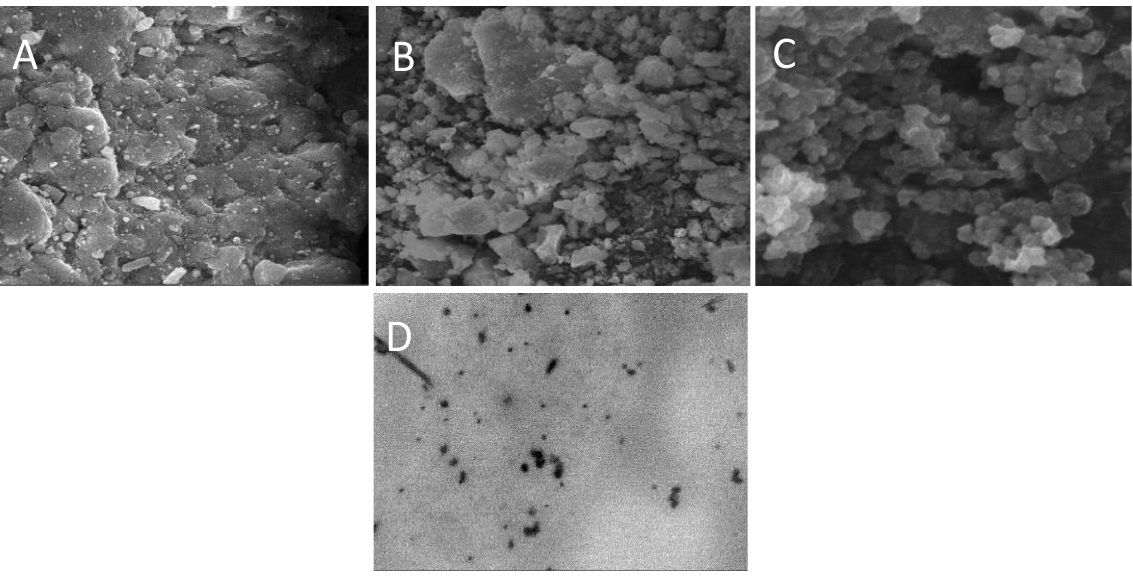
Figure 6. SEM images of ( A ) NP2, ( B ) NP4, ( C ) NP6 and ( D ) TEM image of EPL-SBE 7 β -CD CS/sTPP NPs.